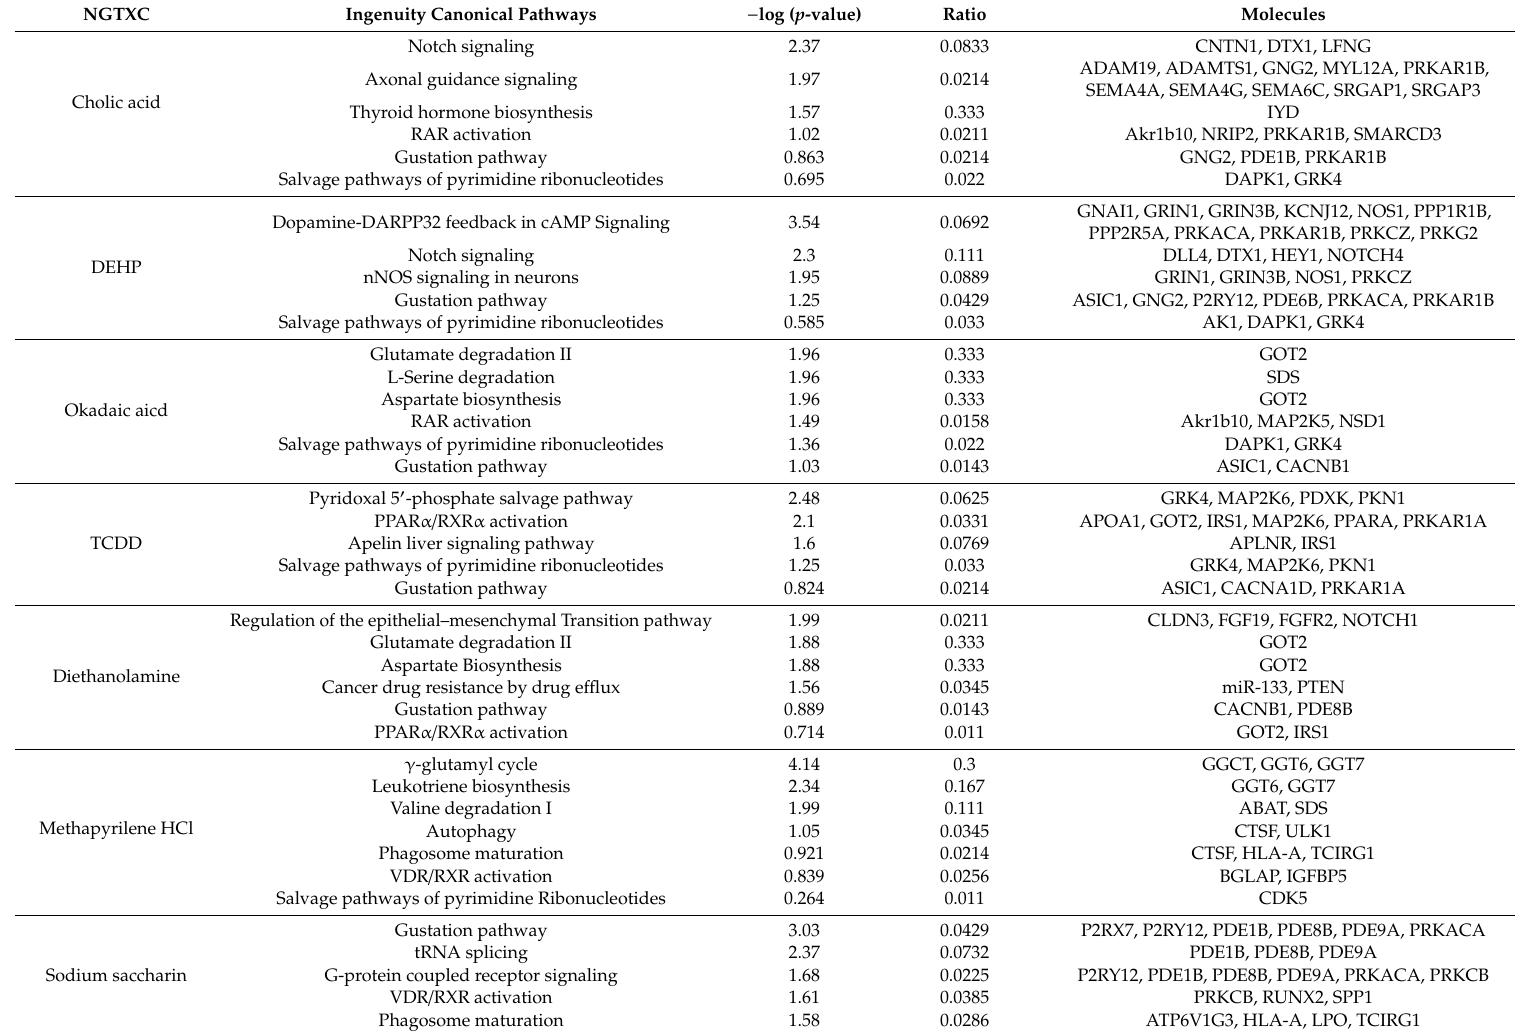
Table 6. Top 3 and the significant canonical pathways of the di ff erentially methylated regions between the control and the NGTXC-treated group ( p -value < 0.05 and proportion of methylation di ff erence >